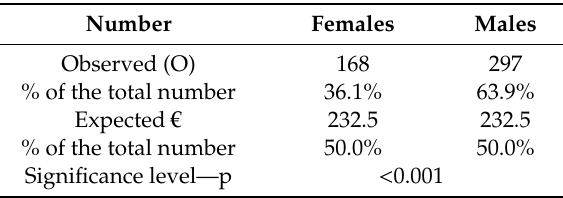
Table 1. Characteristics of the study group.